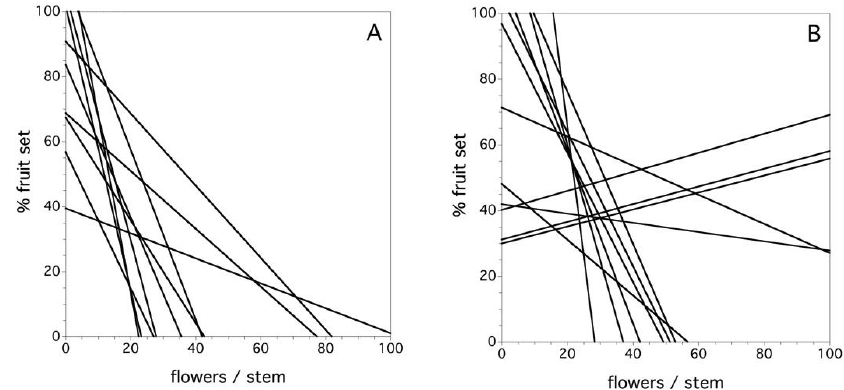
Figure 8. The relationship between flowers/stem and percent fruit set for each clone, ( A ) year 1969 and ( B ) year 2013. Data is not shown because the number of data points obscures the fitted relationships.